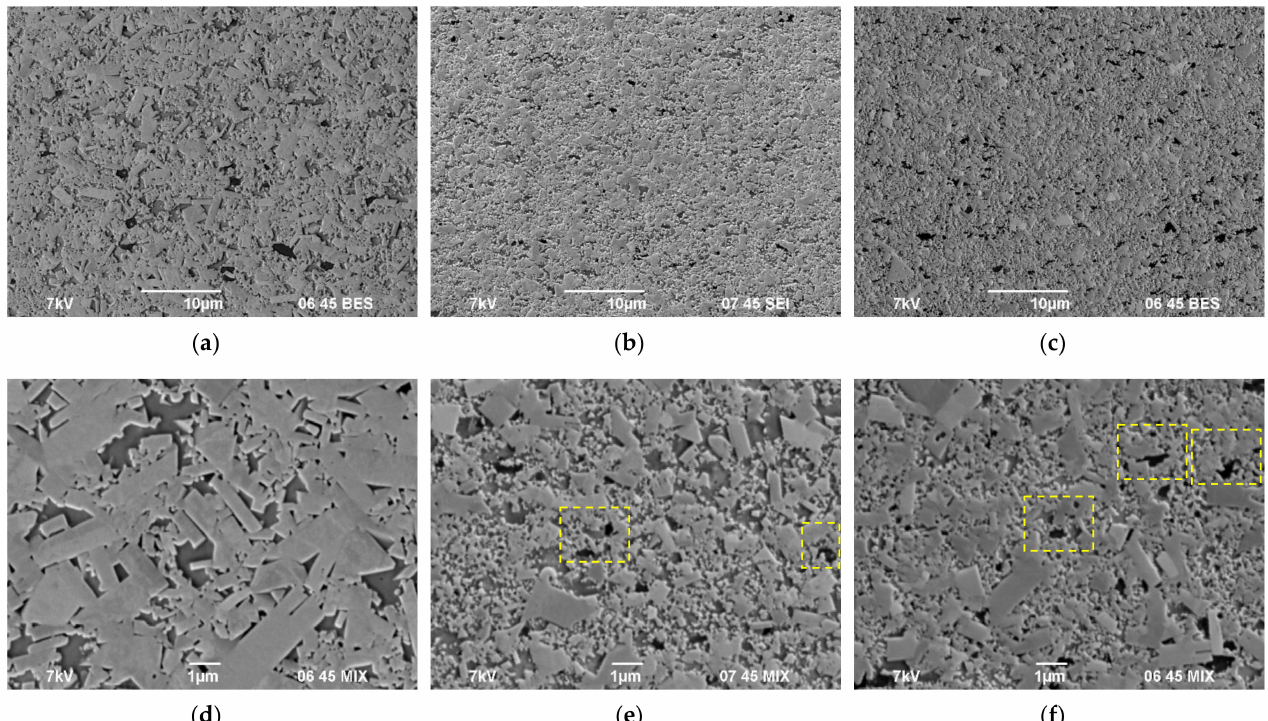
Figure 11. Microstructure of WC-10Co hard alloys obtained by solid-phase SPS of nanopowders with various concentrations of graphite: ( a , d )—0.5 wt.%, ( b , e )—1.0 wt.%, ( c , f )—1.5 wt.%